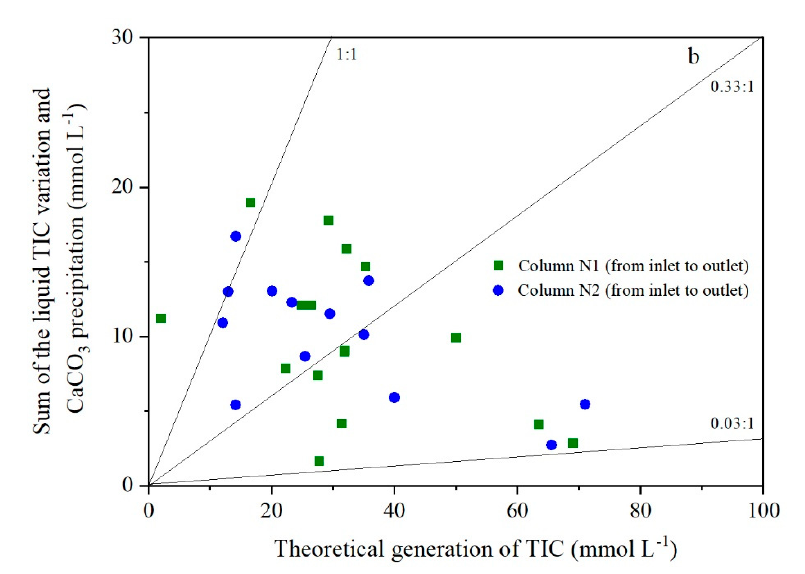
Figure 8. Total inorganic carbon (TIC) retention ratio: ( a ) group G and ( b ) group N.